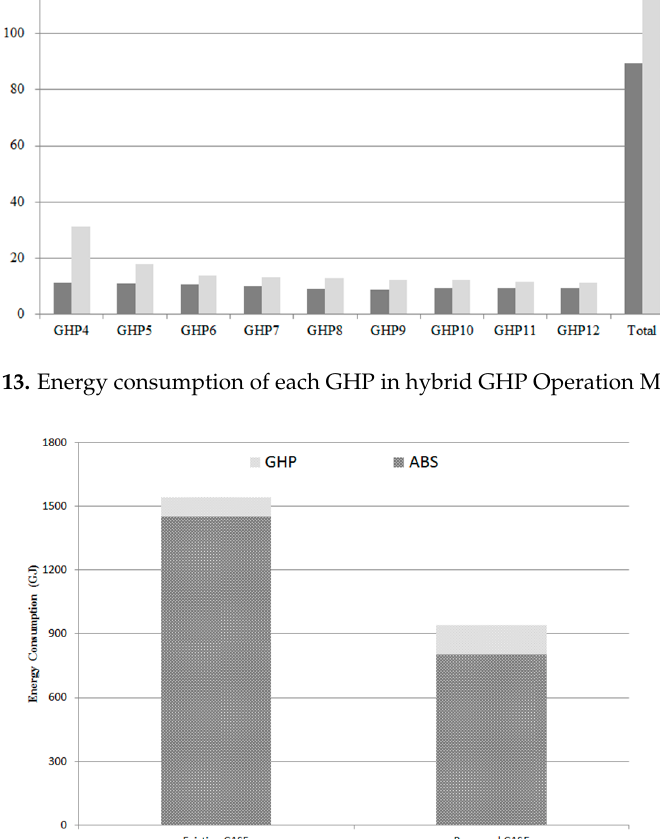
Figure 14. Energy consumption of the absorption chiller ‐ heater and GHP System.